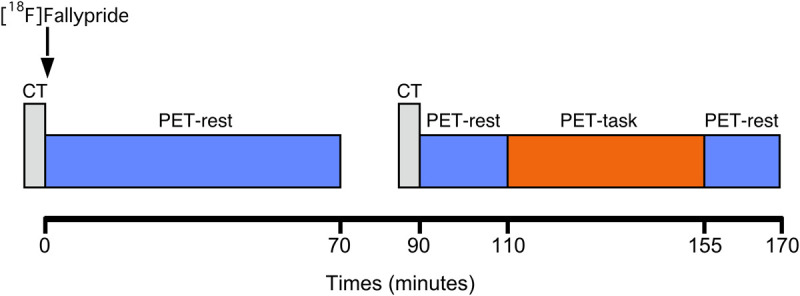
Experimental timeline of the study. PET-rest: eyes-open resting state; PET-task: eyes-open desynchronizing NFB (experimental group) or EMG biofeedback (control group).